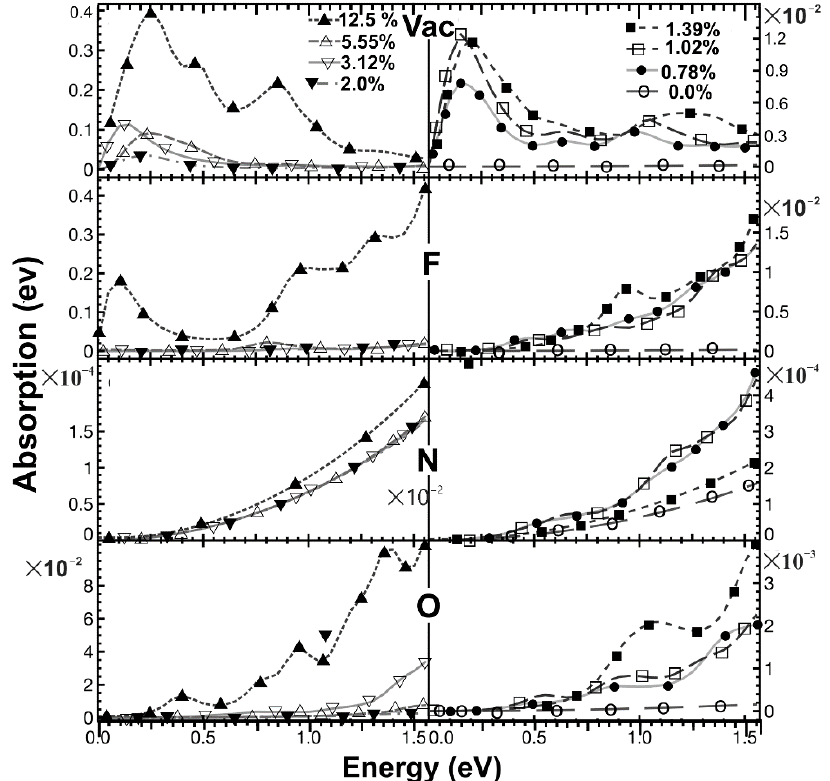
Figure 15. We show the absorption in the infrared region for different dopant (or vacancy) concen- trations. For 0% (pristine graphene): O; for 0.78%: • ; for 1.02%: (cid:3) ; for 1.39%: (cid:4) ; For 2.0%: (cid:72) ; for 3.12%: (cid:53) ; for 5.55%: (cid:52) ; for 12.5%: (cid:78) . At the top, we have the absorption for different vacancy concentrations. At the bottom, we have the optical absorption for different oxygen percentages. As in the two previous cases, we show the absorption for fluorine and nitrogen for the same concentration variation in the middle. The horizontal axis marks the energy of incident electromagnetic radiation.